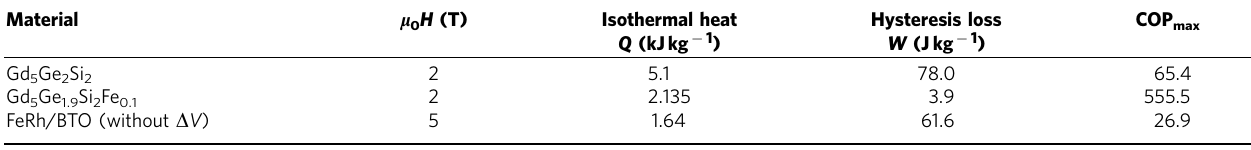
Table 1 | Comparison of magnetocaloric properties between Gd 5 Ge 2 Si 2 and FeRh.